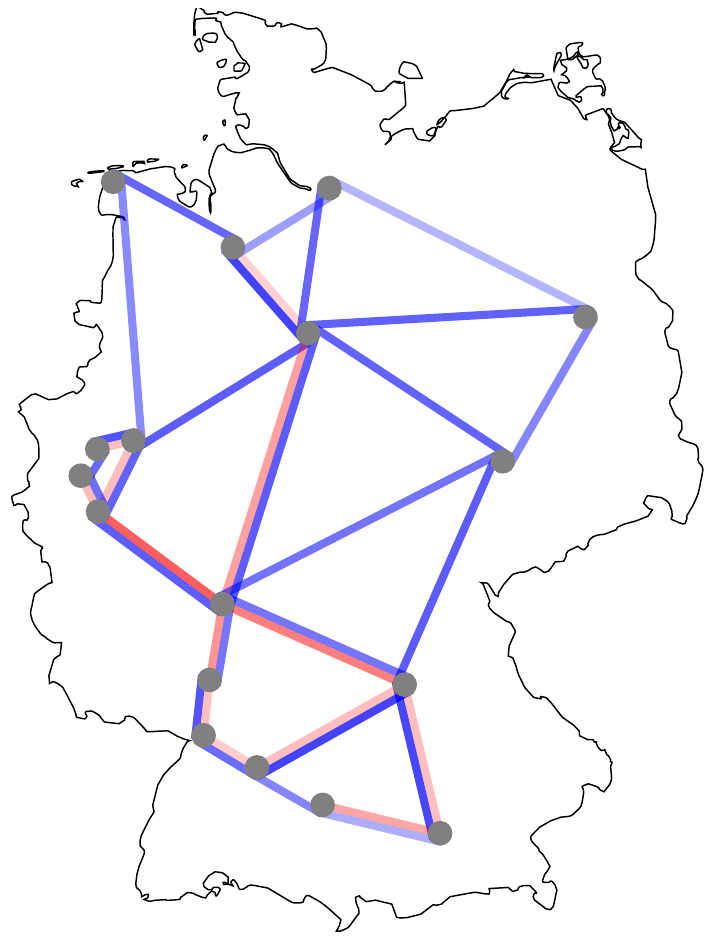
Figure 15. Wavelength assignment for band C and L (with max demand) for German